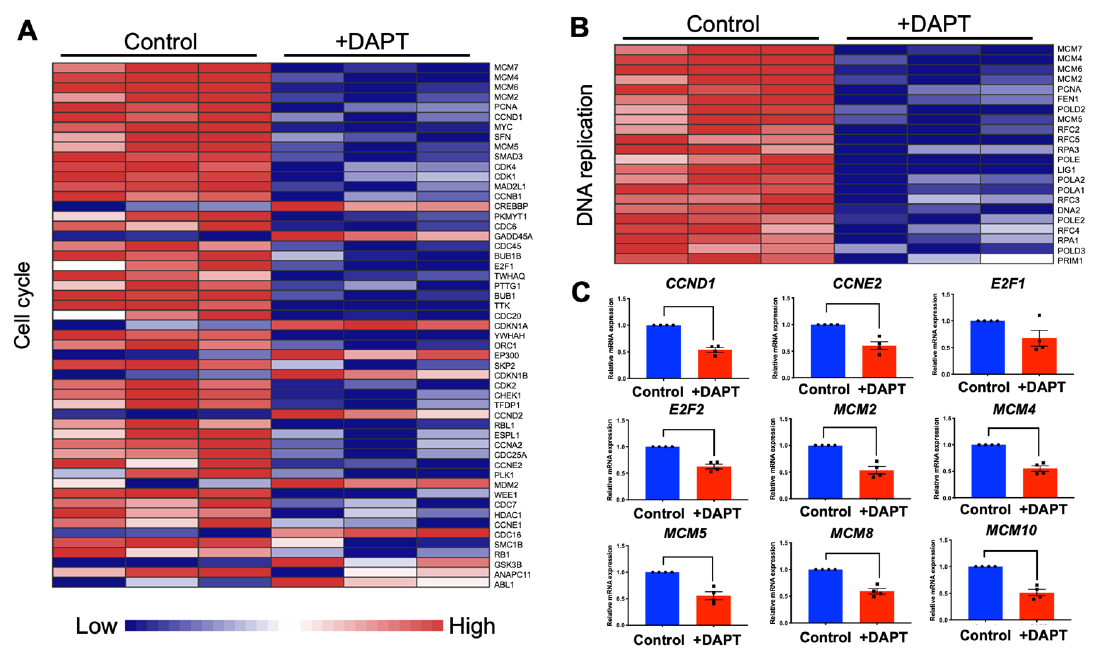
Figure 3. DAPT treatment reduced the expression of genes related to the cell cycle and DNA replication. ( A ) Heatmap of differential expressed genes in cell cycle pathway ( n = 3). ( B ) Heatmap of differentially expressed genes in the DNA replication pathway ( n = 3). ( C ) The mRNA expression levels of selected genes were determined by qRT-PCR ( n = 4). Bars represent a significant difference between groups ( p < 0.05).